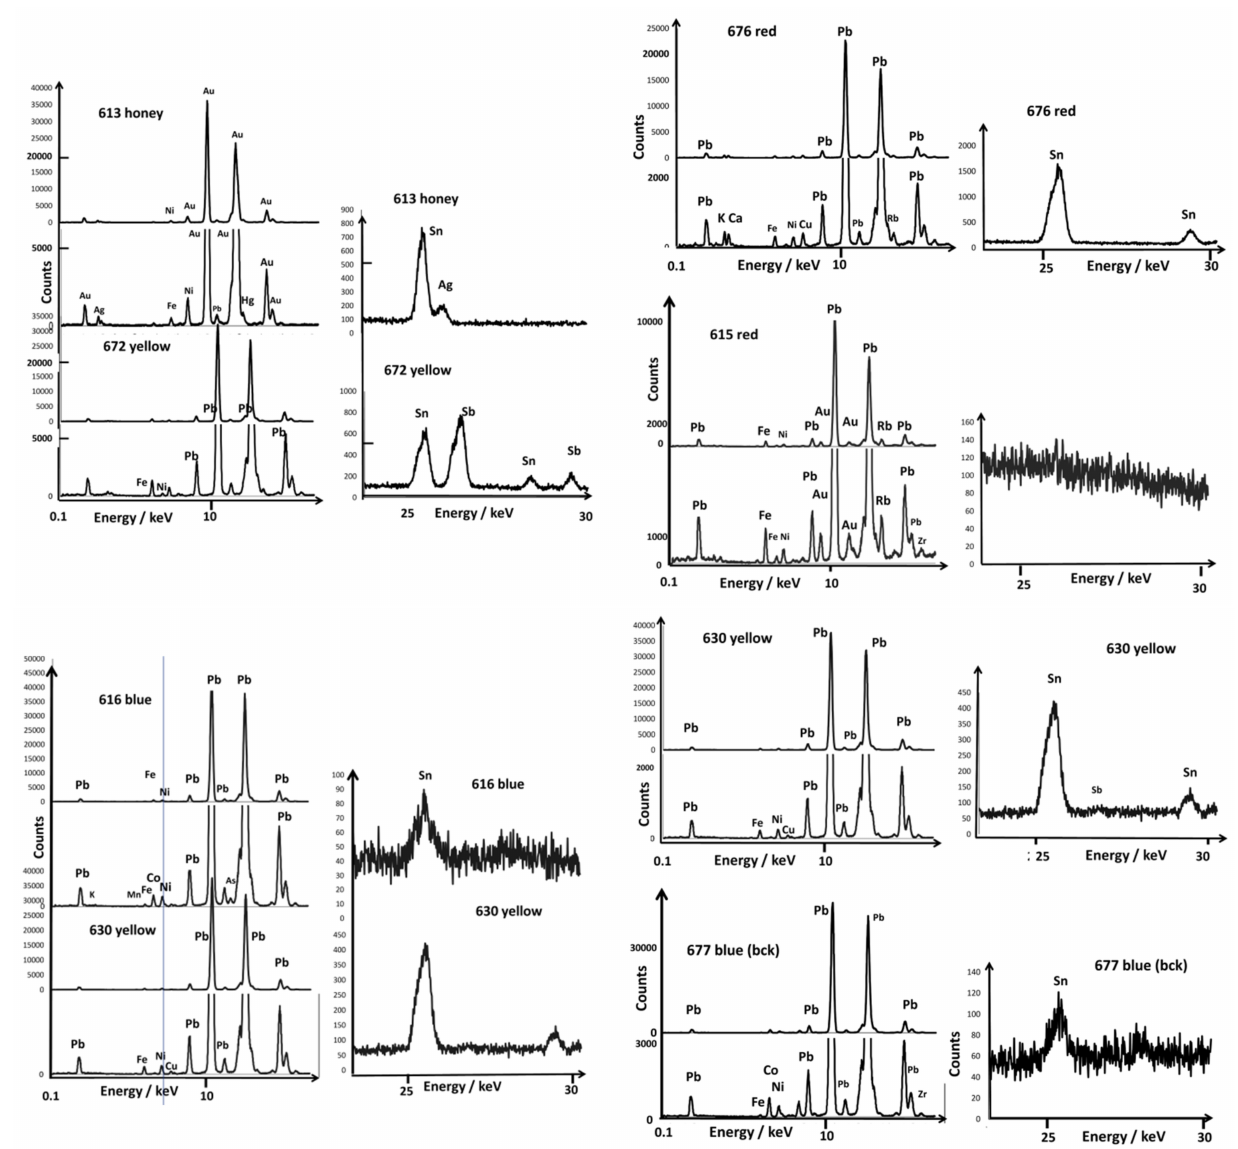
Figure 5. Comparison of the representative XRF spectra for yellow, golden honey, blue, and red backgrounds recorded in the 0.1–20 and 20–30 keV energy ranges; for comparison, some spectra of paste are also given. Line is guide for